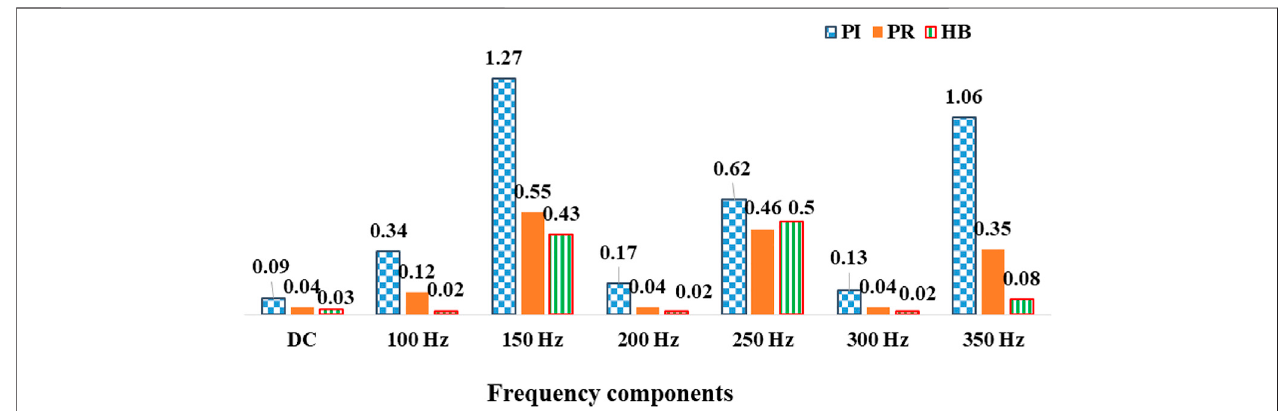
FIGURE 9 | Harmonic content in grid current with PI, PR, and HB